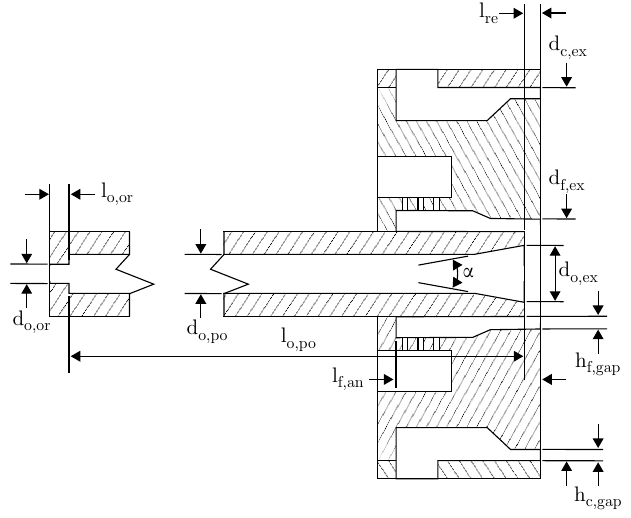
Figure 2. Injection system configuration [25]. Table 1. Geometrical dimensions of injection